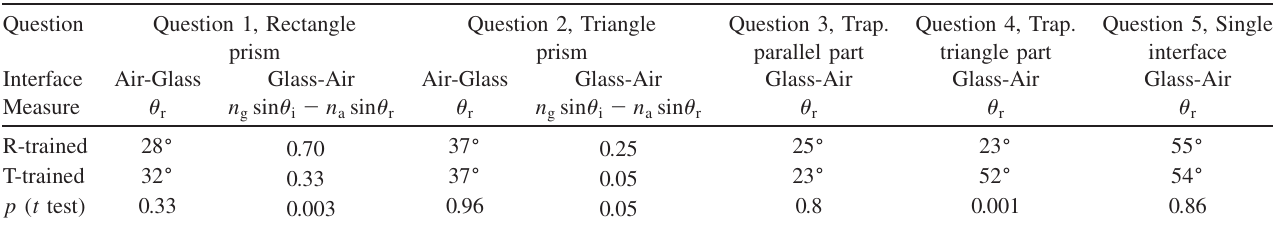
TABLE V. Summary of the angles and measures for calculus students.